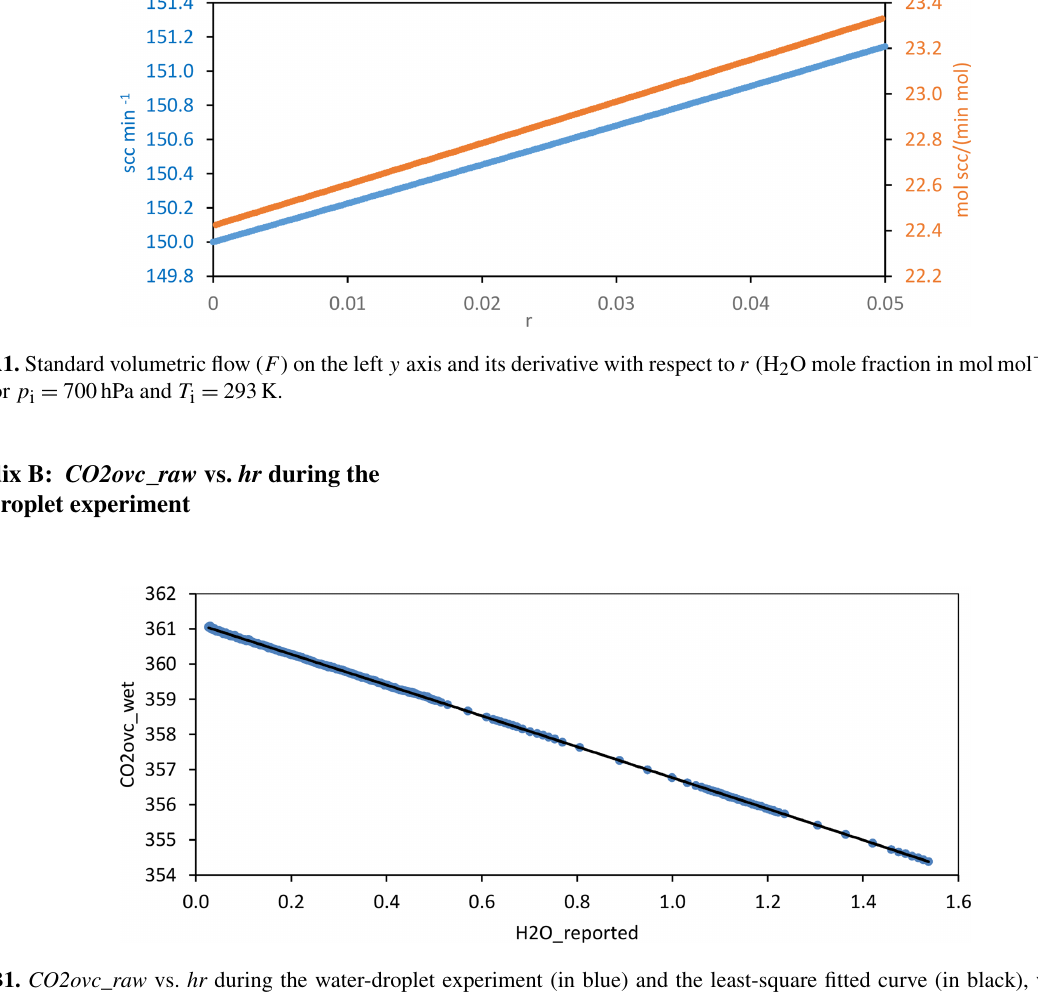
Figure B1. CO2ovc_raw vs. hr during the water-droplet experiment (in blue) and the least-square fitted curve (in black), where only the 0.0–1.55 hr range has been